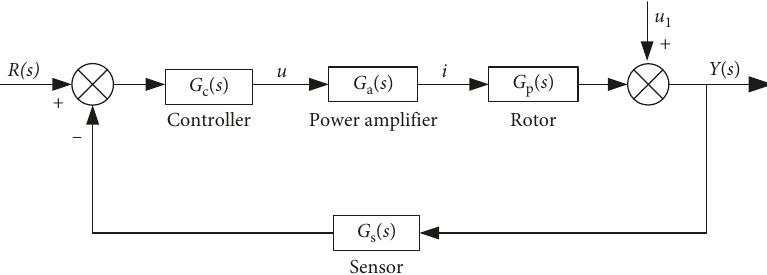
Figure 3: Block diagram of one degree of freedom AMB control